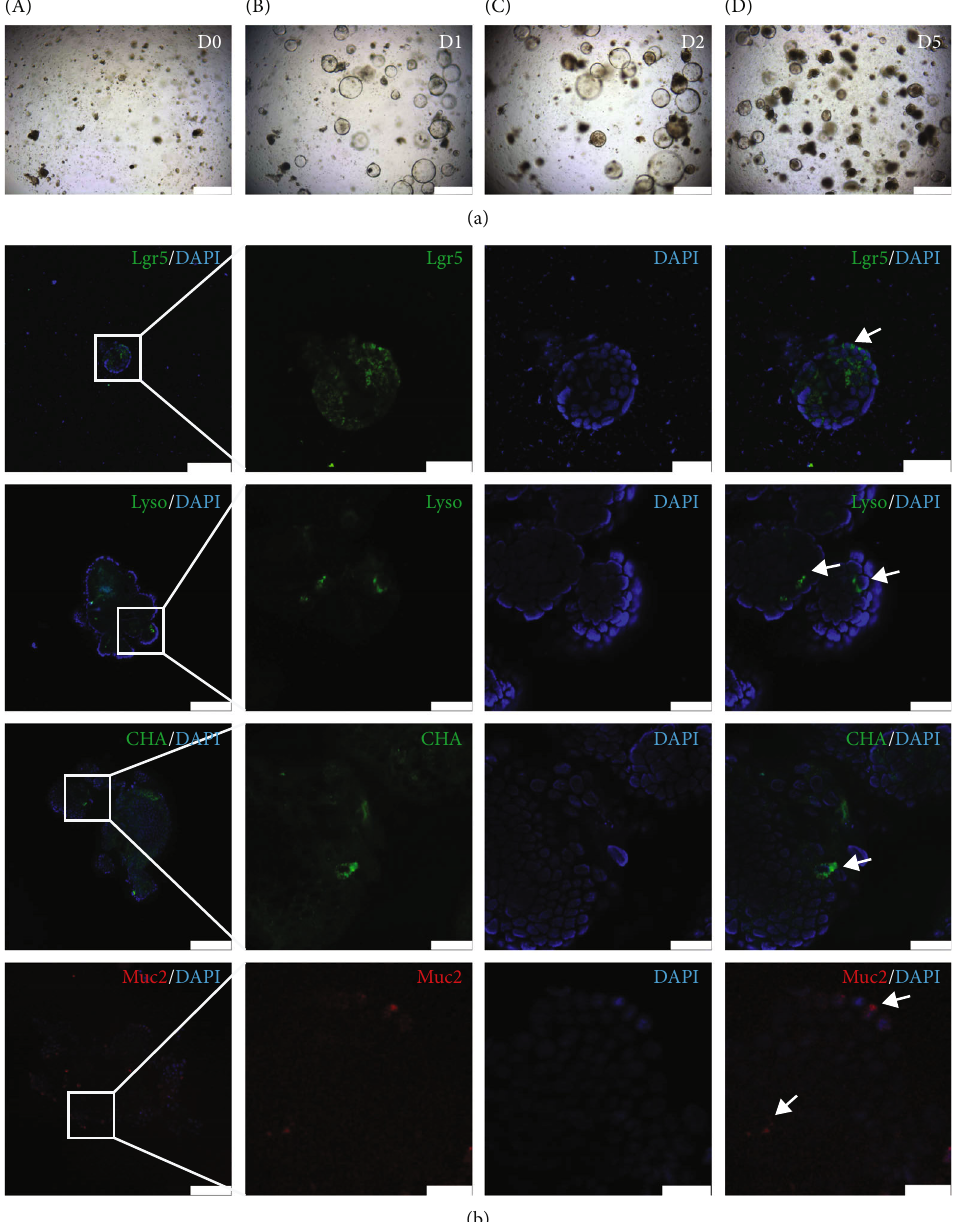
Figure 3: The growth trajectory and epithelial cell type identi fi cation of intestinal organoids with epithelial in fl ammatory injury. (a, A – D) Images taken at day 0, day 1, day 2, and day 5, respectively. Scale bars = 500 μ m. (b) Cell type diversity of intestinal organoids with epithelial in fl ammatory injury identi fi ed by immuno fl uorescence staining. Confocal image for Lgr5 (green, intestinal stem cell), lysozyme (Lyso, green, Paneth cell), chromogranin A (CHA, green, intestinal endocrine cell), and Muc2 (red, goblet cell). DAPI (blue) for nucleus. The arrows pointed to the positive cells. Scale bars = 100 μ m ( fi rst column). Scale bars = 20 μ m (second, third, and fourth UK), occludin 1 : 100 (A ffi nity, China), and claudin-1 (Figure 4(c); in this way, the proteins on cell membrane 1 : 100 (A ffi nity, China) were used and incubated at 4 ° C could be well displayed, such as tight junction proteins) [16]. Organoids (on the slide) were washed and perme- overnight. The primary antibodies were then removed, abilized with 0.4% Triton X-100 in PBS (Sigma-Aldrich, followed by incubation with goat anti-rabbit IgG (H+L) USA) for 10 min and blocked with 3% bovine serum albu- cross-adsorbed secondary antibody 1 : 500 (Invitrogen, min (Sigma-Aldrich, USA) in PBS for 1 h. Primary anti- USA) and goat anti-mouse IgG (H + L) secondary antibody bodies Ki67 1 : 400 (Abcam, UK), Lgr5 1 : 100 (A ffi nity, 1 : 500 (Invitrogen, USA) for 1 h at room temperature in the China), Muc2 1 : 100 (Abcam, UK), lysozyme (Lyso) 1 : 100 dark. Nuclei were stained with DAPI (Solarbio, China). (Abcam, UK), chromogranin A1 (CHA) 1 : 100 (Abcam, Images of organoids were taken by confocal microscopy